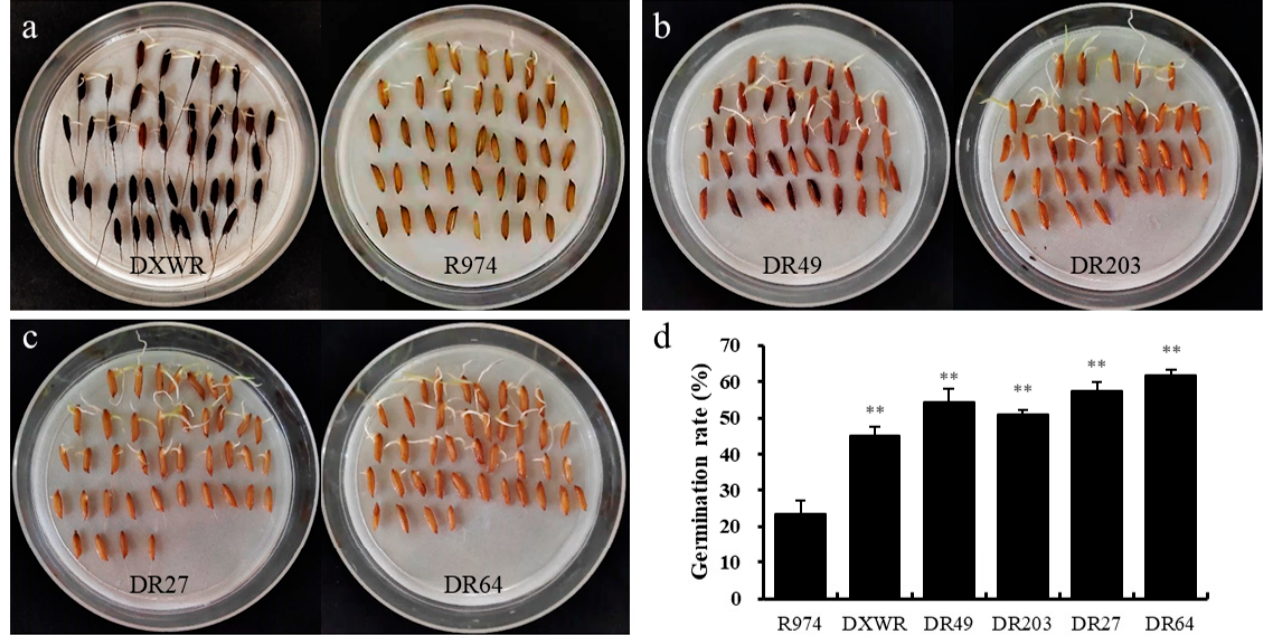
Figure 4. Germination rates of the parents and the four BILs after aging treatment. ( a ) Comparison of germination rates between DXWR and R974 after aging treatment. ( b ) phenotype chart of DR49 and DR203. ( c ) phenotype chart of DR27 and DR64. ( d ) average germination rates of parents and four BILs after aging treatment. Significant differences are indicated by asterisks (Student’s t -test; ** p -value <